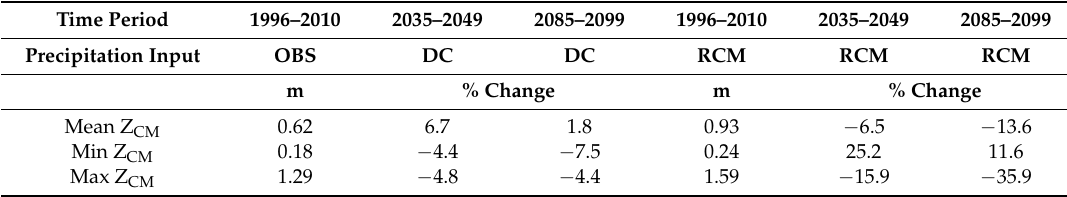
Table 1. The values of Z CM in today’s climate (m) and its estimated future change (%) for a sandy soil in Malmö for different rainfall data inputs: observed (OBS), direct RCM output (RCM), and tailored RCM output by Delta Change